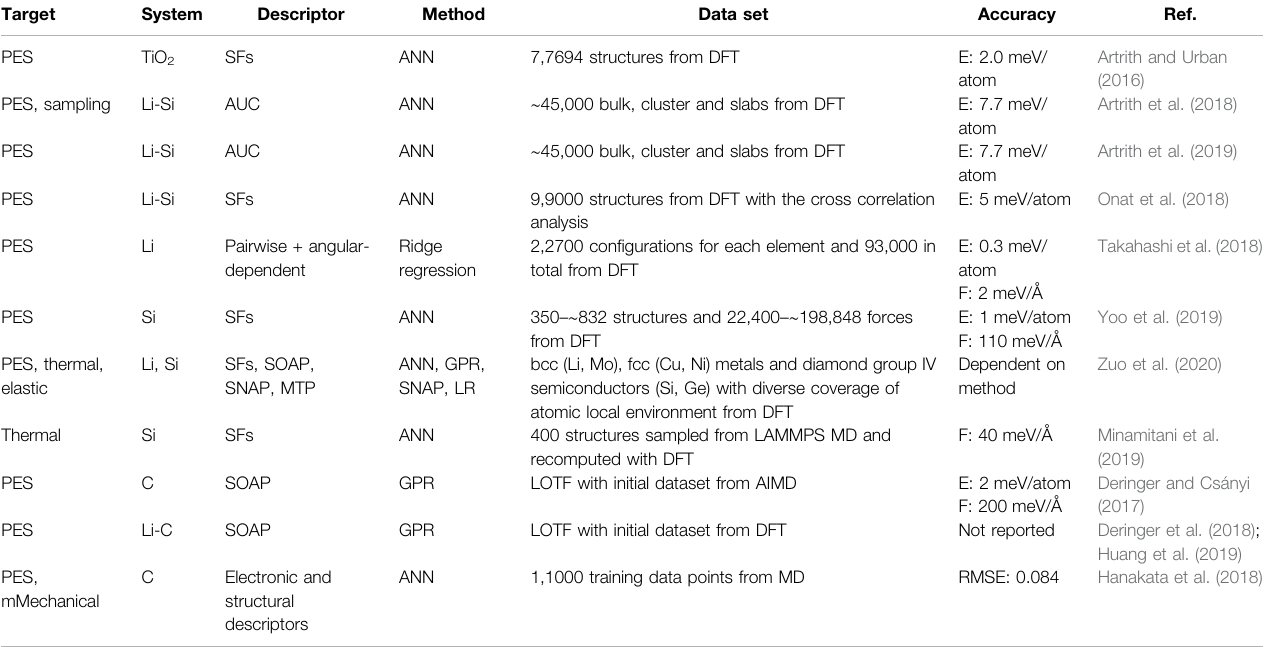
TABLE 2 | Summary of ML applications in anode